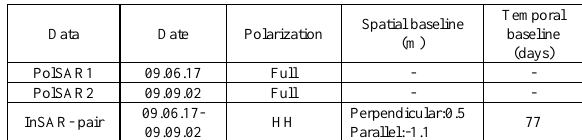
Perpendicular:0.5 Parallel:-1.1